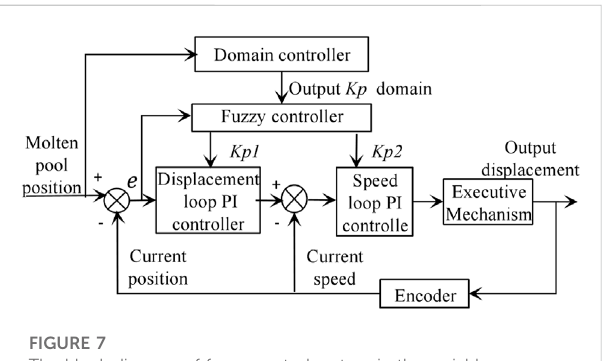
FIGURE 7 The block diagram of fuzzy control system in the variable domain.